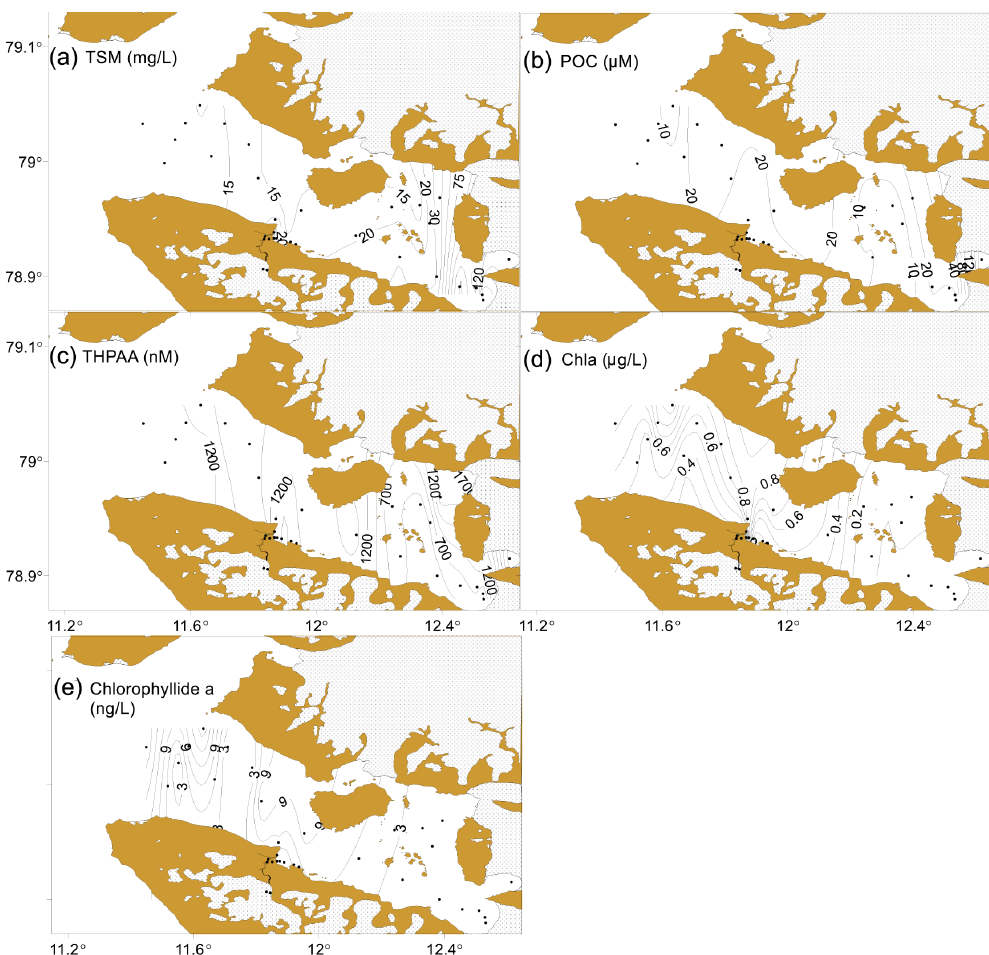
Figure 2. Surface (a) total suspended matter (TSM), (b) particulate organic carbon (POC), (c) total hydrolyzable particulate amino acids (THPAA), (d) chlorophyll a (Chl a ) and (e) chlorophyllide a distribution in the Kongsfjorden. Table 2. Dissolved inorganic nutrients (mean (min–max)) in this study